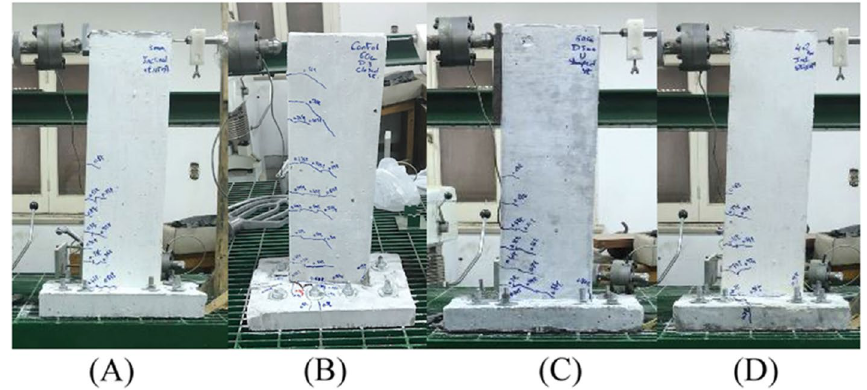
Fig. 9 Walls with varying stirrup detailing from A inclined stirrups with 3mm VL RFT, B closed stirrups, C U-shaped stirrups, and D inclined stirrups with 4